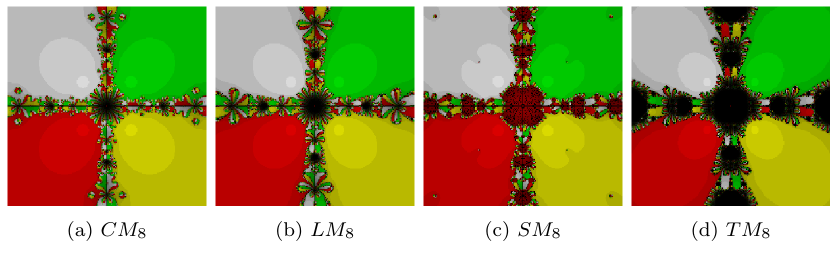
Figure 1. The methods for test problem 1.